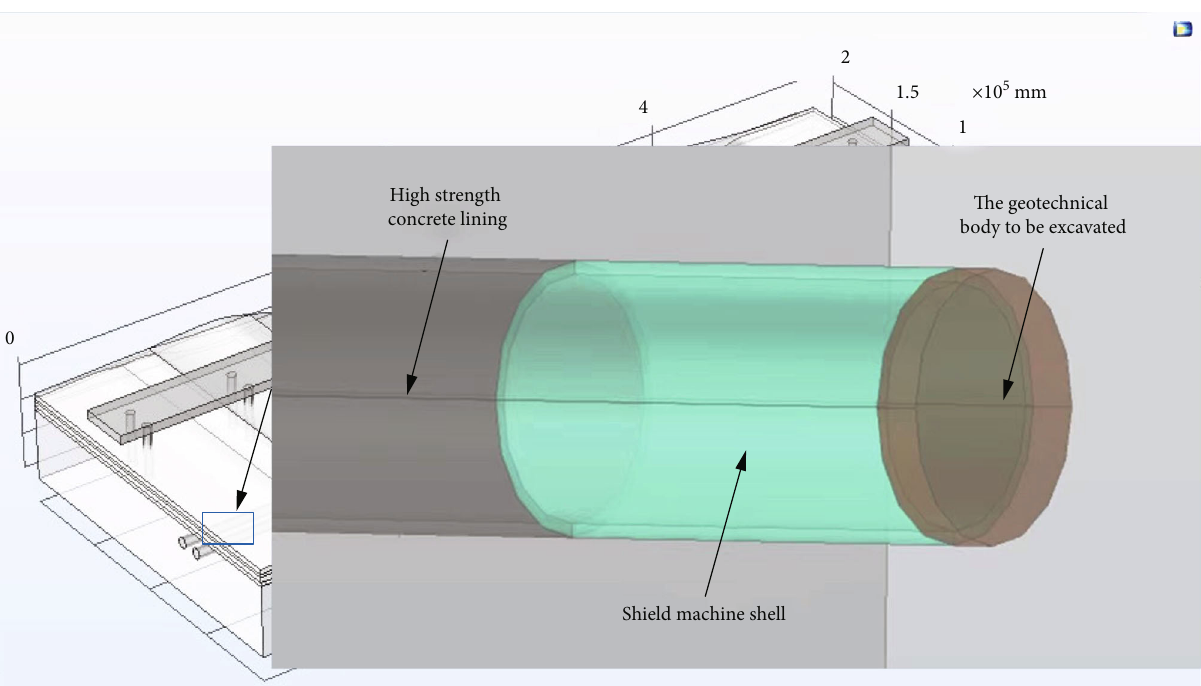
Figure 6: Simpli fi ed schematic diagram of shield machine in the numerical